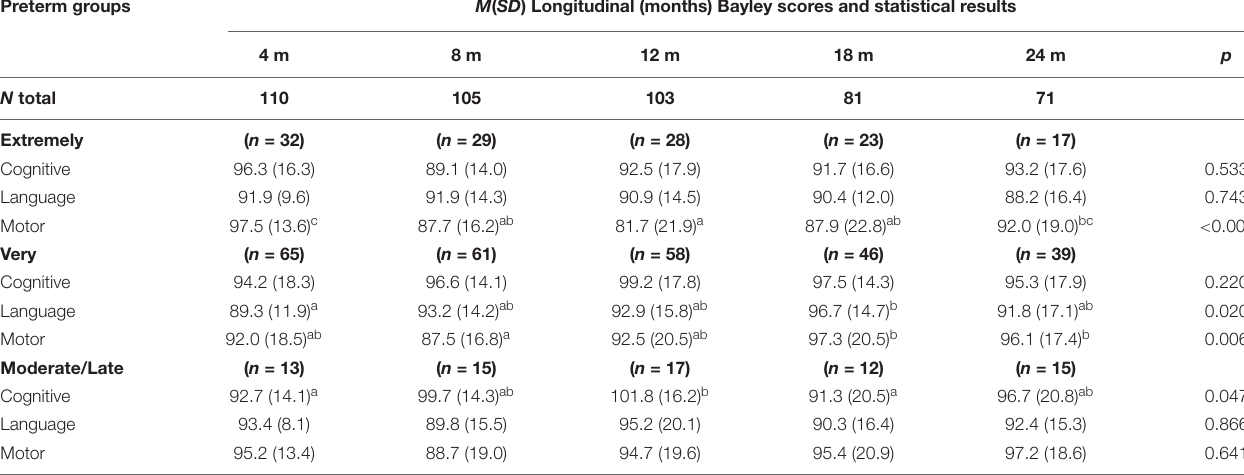
TABLE 5 | Developmental trajectories: cognitive, language, and motor composite scores by groups and results. Preterm